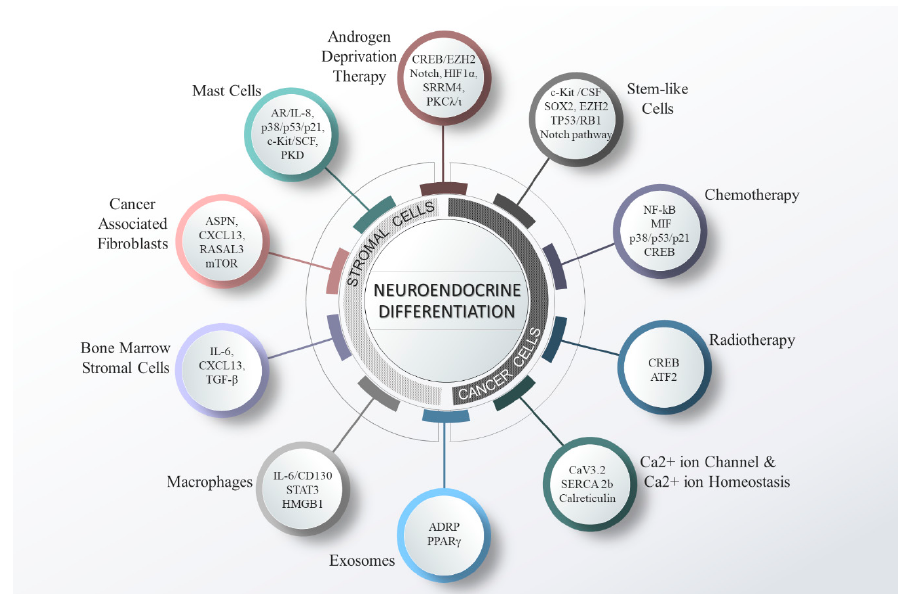
Figure 2. The diverse factors (cellular, molecular and therapeutic) involved in mediating neuroendocrine differentiation (NED) in PCa. Various factors that affect PCa cells include androgen deprivation-, radio- and chemo-therapy. In addition, the cells of tumor microenvironment (TME) including mast cells, cancer associated fibroblasts (CAFs), macrophages and bone marrow stromal cells (BMSCs) have been shown to promote the NED. Furthermore, calcium ion channels and alteration in calcium ion homeostasis play crucial roles in drug resistance and NED. In addition, Exosomes secreted from PCa cells have also been associated with NED. A few examples of molecular pathways are represented.